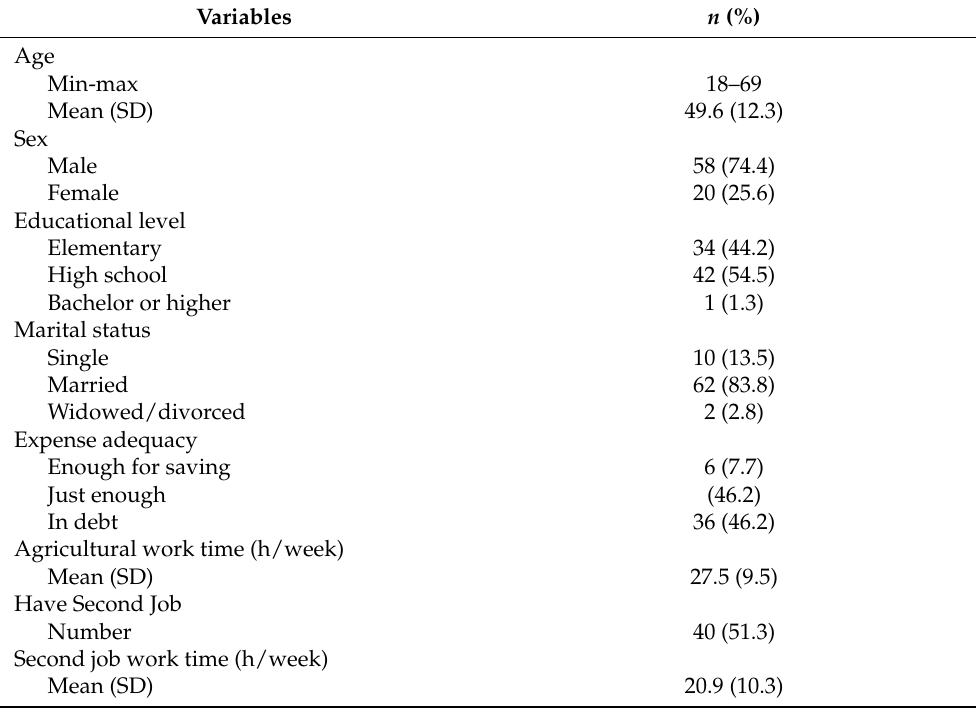
Table 1. Demographic characteristics of conventional farmers ( n = 78) spraying chlorpyrifos, cyper- methrin, glyphosate or